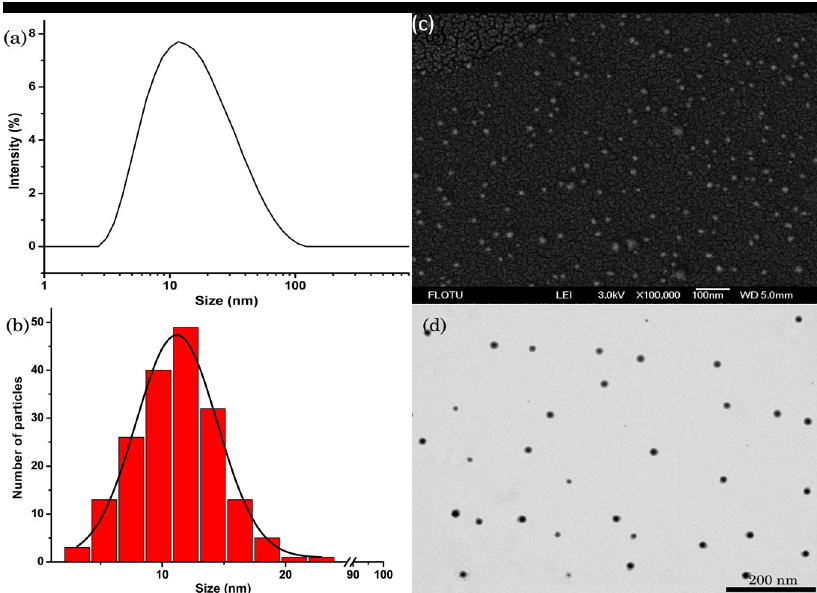
Figure 2. DLS and SEM characterization of the nanosuspension: ( a ) Particle size distribution based on DLS; ( b ) Particle size distribution based on SEM image; ( c ) SEM image of the lambda-cyhalothrin nanoparticles; ( d ) TEM image of the lambda-cyhalothrin